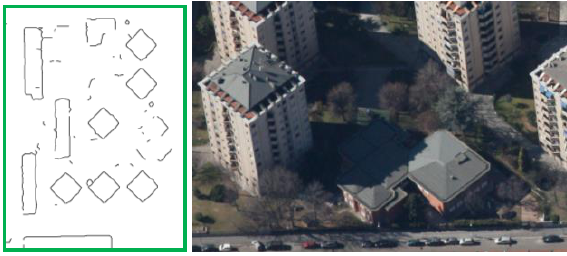
Figure 10. Example of incomplete footprint’s extraction due to the occlusions given by trees.